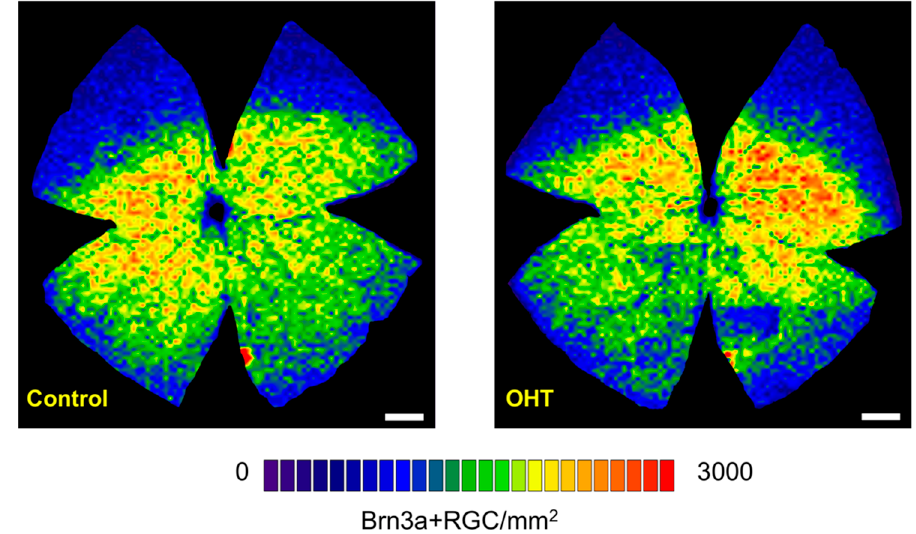
Figure 6. E ff ect of chronic IOP elevation on Brn3a + RGC isodensity maps. Isodensity maps showing the distribution of Brn3a + RGCs in a control and its contralateral treated retina. There were no significant di ff erences in the total numbers of Brn3a + RGCs ( p > 0.05) at the 12 week follow-up. This is a representative image of a typical distribution of Brn3a + RGCs across the retina. Brn3a + RGCs are denser in the central and medial retina and scanter in the periphery. Density color scale ranges from 0 (dark blue) to 3000 (red) Brn3a + RGCs / mm2 or higher. The dorsal pole is located at the 12 o’clock position for all retinas. Scale bar = 1